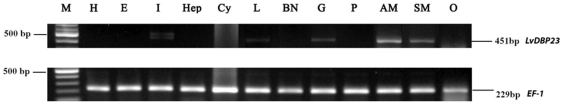
Tissue specificity of LvDBP23 gene expression by RT-PCR.
LvDBP23 mRNA was detected in abdominal muscle (AM) and swimming leg muscle (SM) but weakly in intestine (I), lymphoid (L) and Gill (G). EF-1 gene was used as a control gene. Abbreviations in the picture represented marker (M), heart (H), eyestalk (E), intestine (I), hepatopancreas (Hep), haemocyte (Cy), lymphoid (L), brain and nerve ganglion (BN), gill (G), pleopods (P), abdominal muscle (AM), swimming leg muscle (SM) and ovary (O).